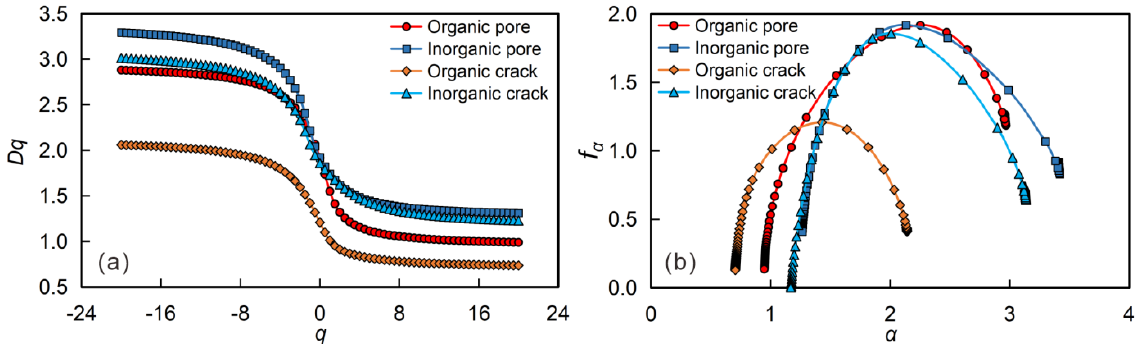
Figure7. (a) Generalized dimensional and (b) multifractal spectra of four different pore types. Figure 7. ( a ) Generalized dimensional and ( b ) multifractal spectra of four different pore types. Dq decreases rapidly with increasing q when q < 0, and the Dq varies greatly among pore type. Dq decreases slowly with the increase of q when q > 0, and the difference of Dq between pore type was small (Figure 7a). A multitude of pore structure parameters (D 0 , D 1 , D 2 ) can be obtained by Dq-q. D 0 refers to the capacity dimension characterizing the average pore structure distribution and reflecting the pore structure complexity [48]. The in- formation dimension and the correlation dimension are denoted as D 1 and D 2 , respectively.